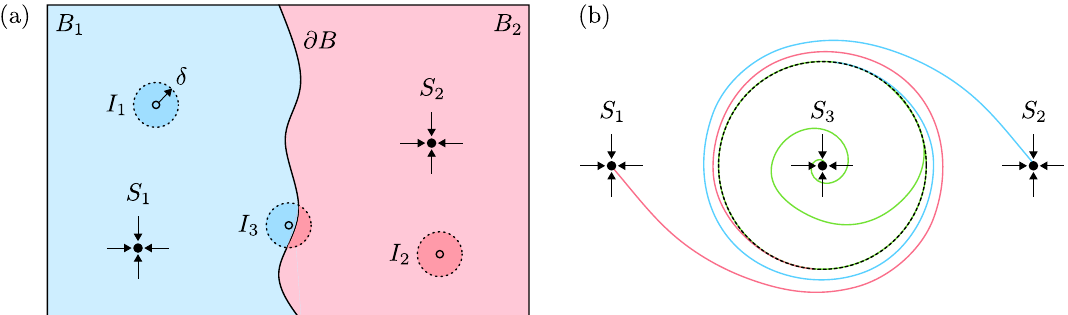
Figure 8. ( a ) Two-dimensional schematic, demonstrating how unpredictability can arise at a smooth basin boundary ∂ B . The basins of attraction, denoted by B 1 and B 2 , are the sets of initial conditions that evolve towards the fixed point attractors S 1 and S 2 , respectively. The initial conditions I 1 , I 2 and I 3 are uncertain within precision δ . ( b ) Two-dimensional schematic demonstrating how a UPO (denoted by the black dashed circle), in the presence of multiple co-existing attractors, can give rise to unpredictability. Two attractors, S 1 and S 2 , lie within the exterior region and a single attractor, S 3 , lies within the interior region. Three arbitrary trajectories emanate from the UPO, each of which evolve towards one of the